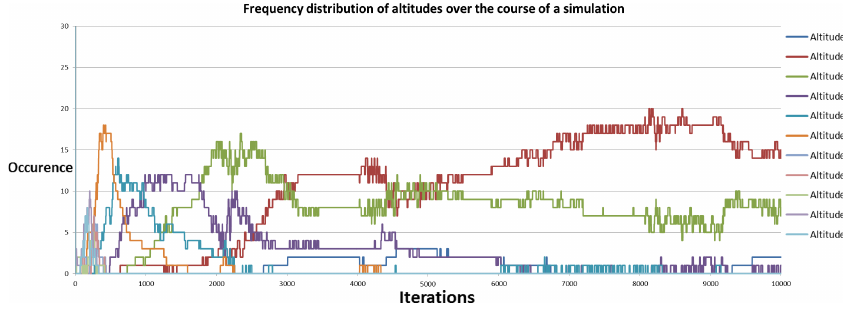
Figure 8. The frequency distribution for the altitudes of the drones.